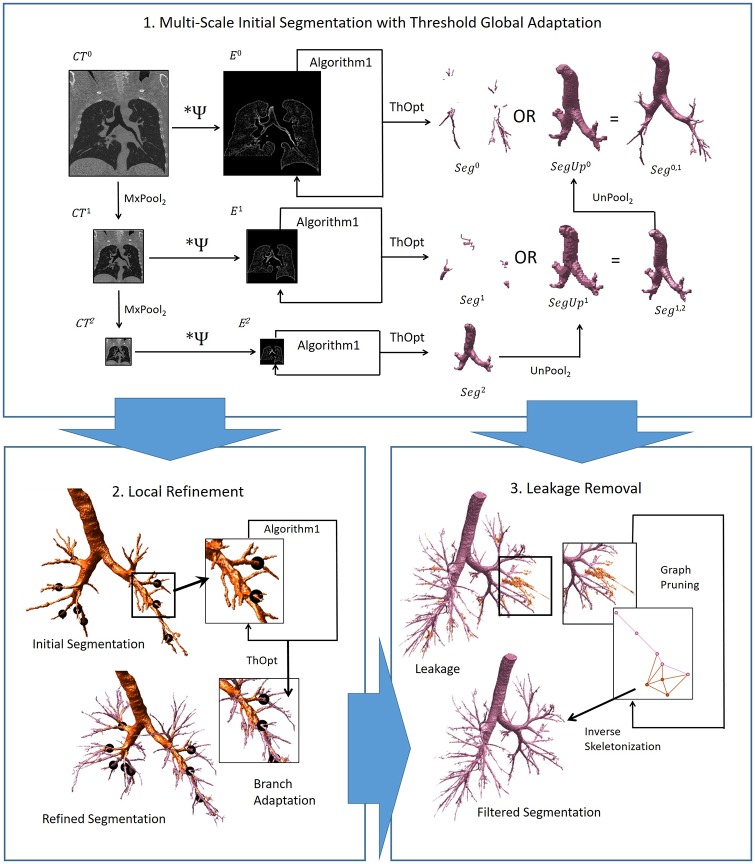
PICASSO main steps.1. Initial segmentation using a multi-scale approach with global adaptation of the threshold. The input data is the original CT scan (left image) and the output are airway segmentations (most right meshes shown in purple) at different scales, one for each down-scaled CT volume. 2. Distal refinement of initial segmentation (upper left orange mesh) with a threshold locally adapted for each distal branch (marked with dark circles). The output refined distal branches are shown in purple in the lower left mesh. 3. Leakage removal by pruning the cycles of the graph representing the segmentation skeleton. The input segmentation with leakage is shown in orange (both in the upper left mesh and graph), while the output filtered leakage-free segmentation is shown in purple.